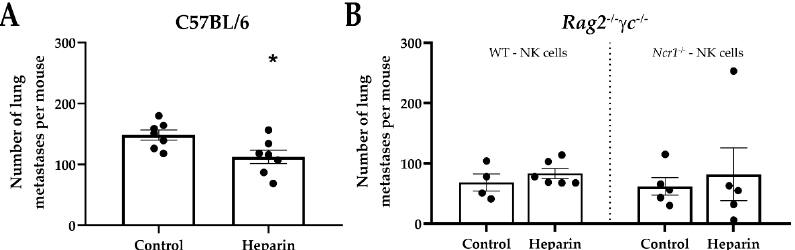
Figure 1. Heparin reduced the number of melanoma lung metastases. ( A ) C57BL / 6 mice were injected intravenously with 2 × 10 5 B16-F10 melanoma cells and treated with heparin (10 mg / kg every 2 days, subcutaneously), starting 1 day after tumor inoculation. After 15 days, mice were euthanized, and lung metastases were macroscopically counted. Graph is representative of two independent